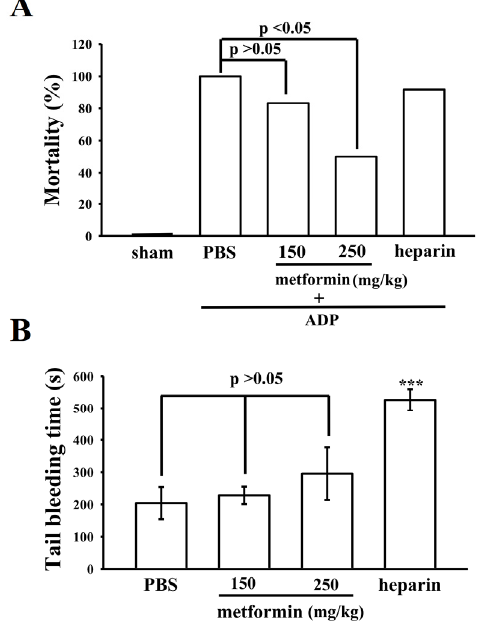
Figure 8. Influence of metformin in acute pulmonary thromboembolism and tail bleeding time in vivo. ( A ) For acute pulmonary thrombosis, PBS or metformin (150 and 250 mg/kg) or heparin (1.5 U/g) was intraperitoneally administered to mice, and ADP (0.7 mg/g) was injected into the tail veins. ( B ) The bleeding time was measured through mouse tail transection after 30 min of intraperitoneal administration of either PBS or metformin (150 and 250 mg/kg) or heparin (1.5 U/g). Results are expressed as mean ± standard error of the mean (( A ), n = 12; (B), n = 8). *** p < 0.001 vs. PBS-treated group. Data in ( A ) are presented as the percentage of mortality.